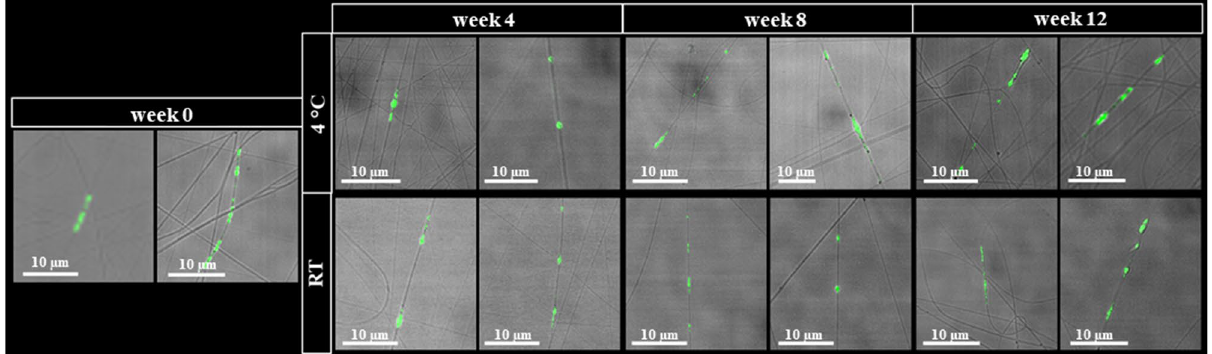
Figure 5. Investigation of the stability of mEV-loaded PVP fibers (PVP-mEV) by confocal laser scanning microscope. The stability of PVP-mEVs kept at 4 °C or RT was monitored for 12 weeks, every four weeks by confocal laser scanning